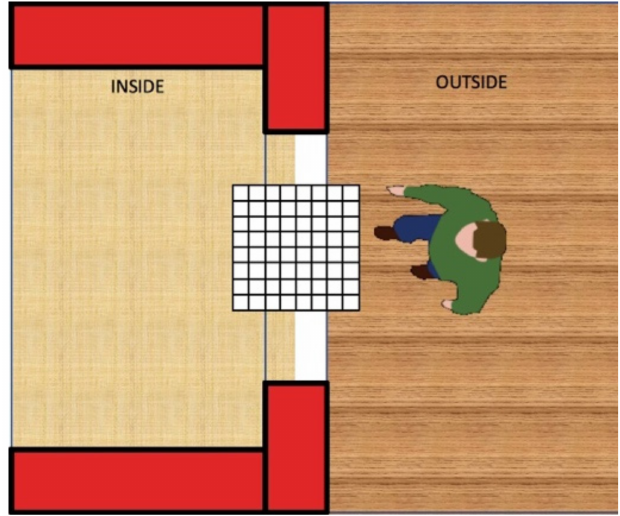
Figure 4. Reference scenario of an event: user’s